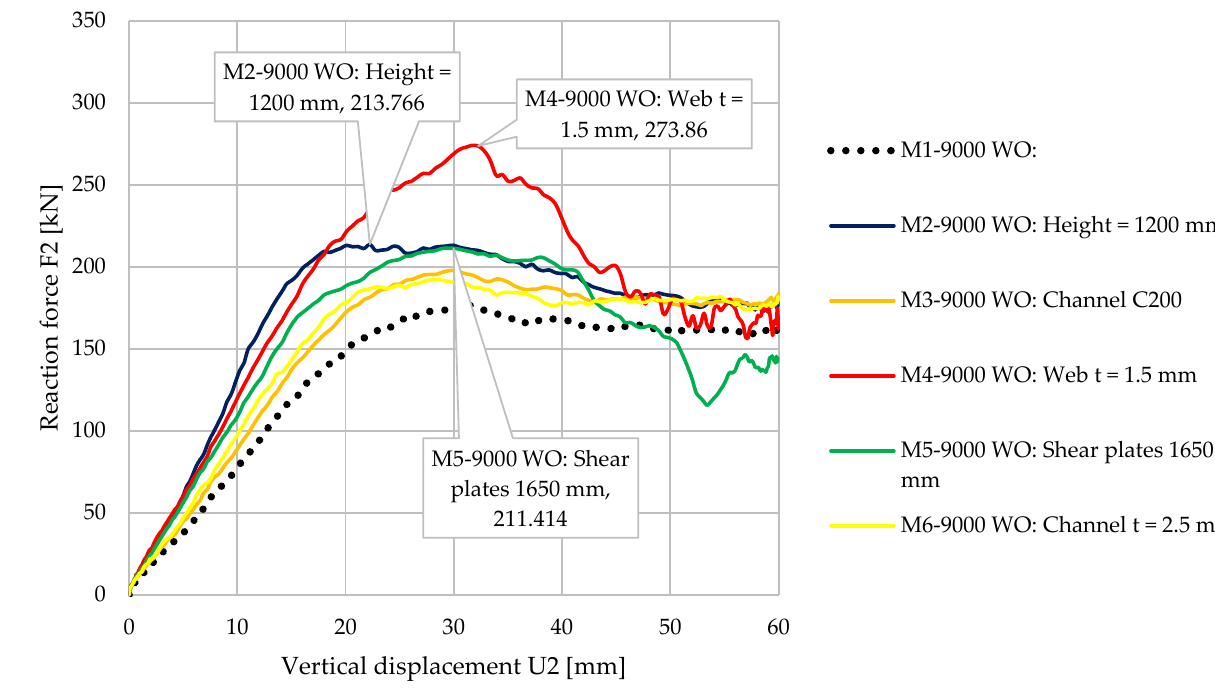
Figure 19. Parametric study for the beam with a web opening and a length of 9000 mm.